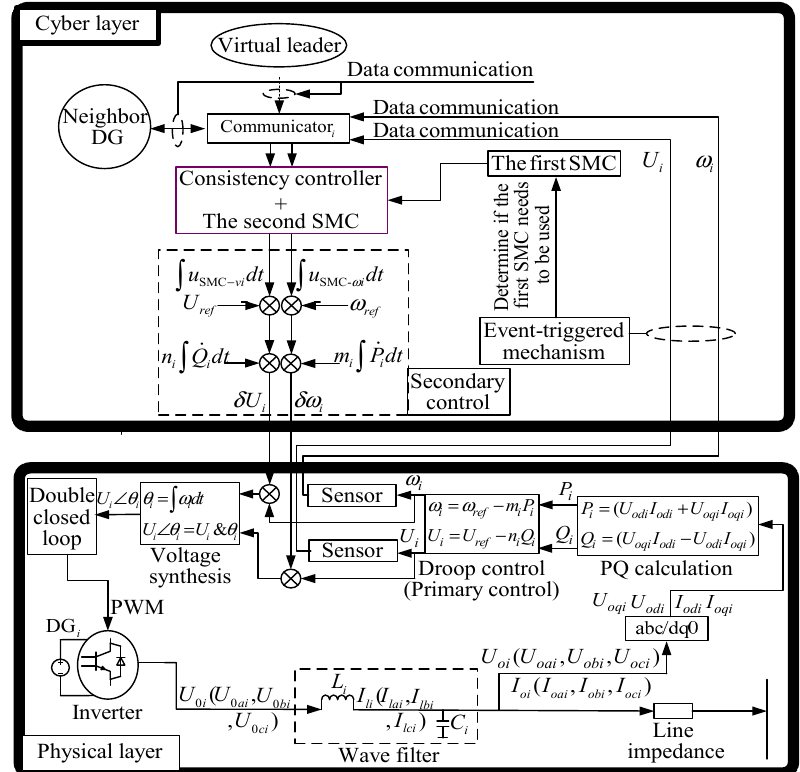
Figure 2. The designed control structure.